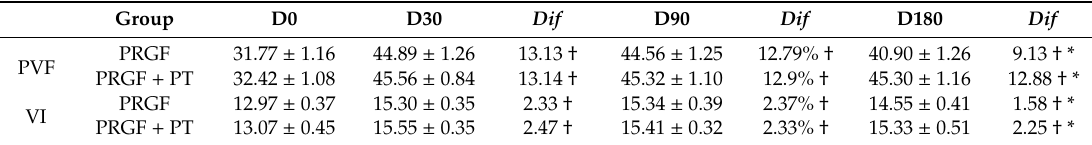
Table 3. Mean ± SD values for PVF and VI for PRGF and PRGF + PT groups at the di ff erent checking periods.